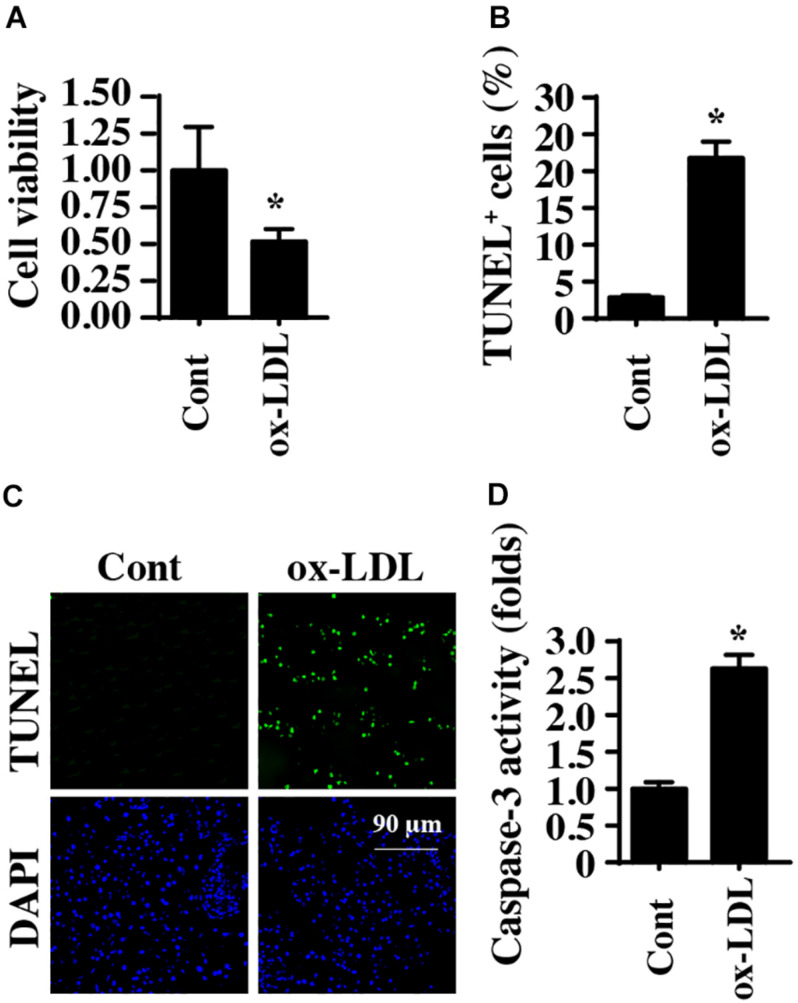
Ox-LDL represses endothelial cell viability and promotes death. (A) An MTT assay was used to observe cell viability in response to ox-LDL treatment. (B,C) TUNEL staining was applied to observe the number of TUNEL-positive cells in response to ox-LDL treatment. (D) An ELISA was used to determine caspase-3 activity in endothelial cells. *p < 0.05.